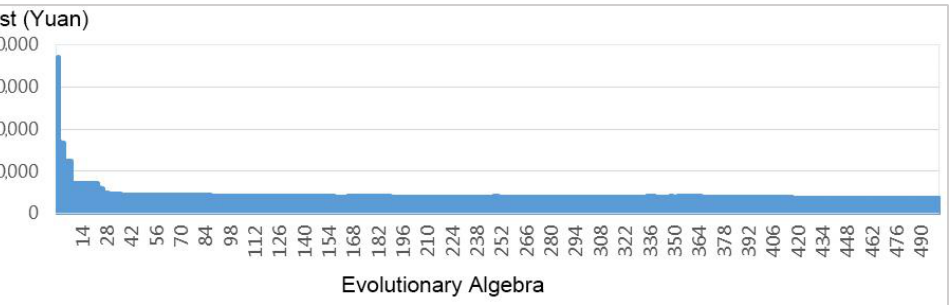
Figure 6. Minimal value evolutionary process in the Pareto optimal solution of economic cost objectives.